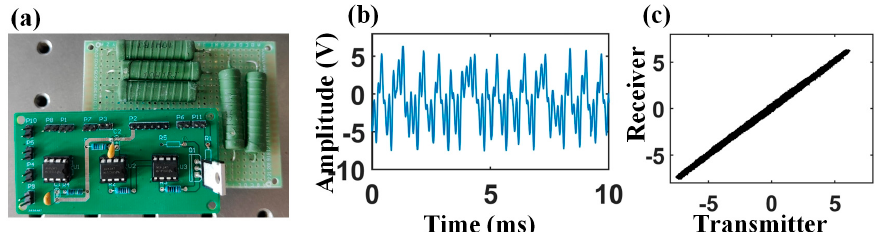
Figure 7. ( a ) Physical equipment of the amplifying matching circuit, ( b ) temporal waveform after amplifying, and ( c ) cross-correlation between chaotic circuit 1 and chaotic circuit 2.